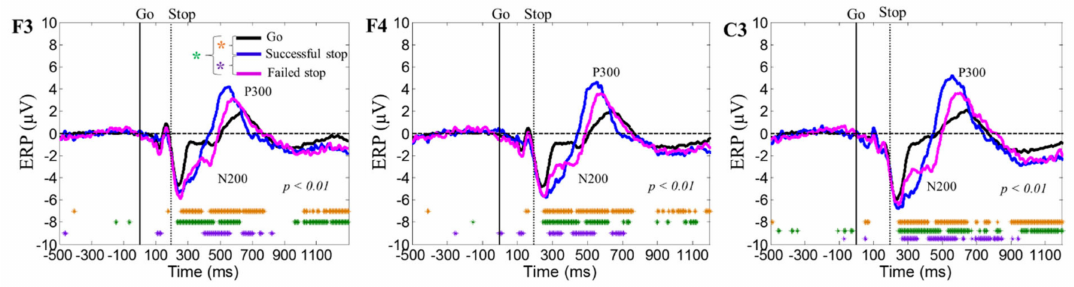
Figure 5. The average event-related potential (ERP) during go, successful stop, and failed stop trials at F3, F4, and C3 channels. Yellow asterisks indicate pairwise significance ( p < 0.01) in Wilcoxon signed-rank test between the go and successful stop conditions. Green asterisks show pairwise significance ( p < 0.01) in Wilcoxon signed-rank test between the go and failed stop. Violet asterisks show pairwise significance ( p < 0.01) in Wilcoxon signed-rank test between the successful and failed stop.